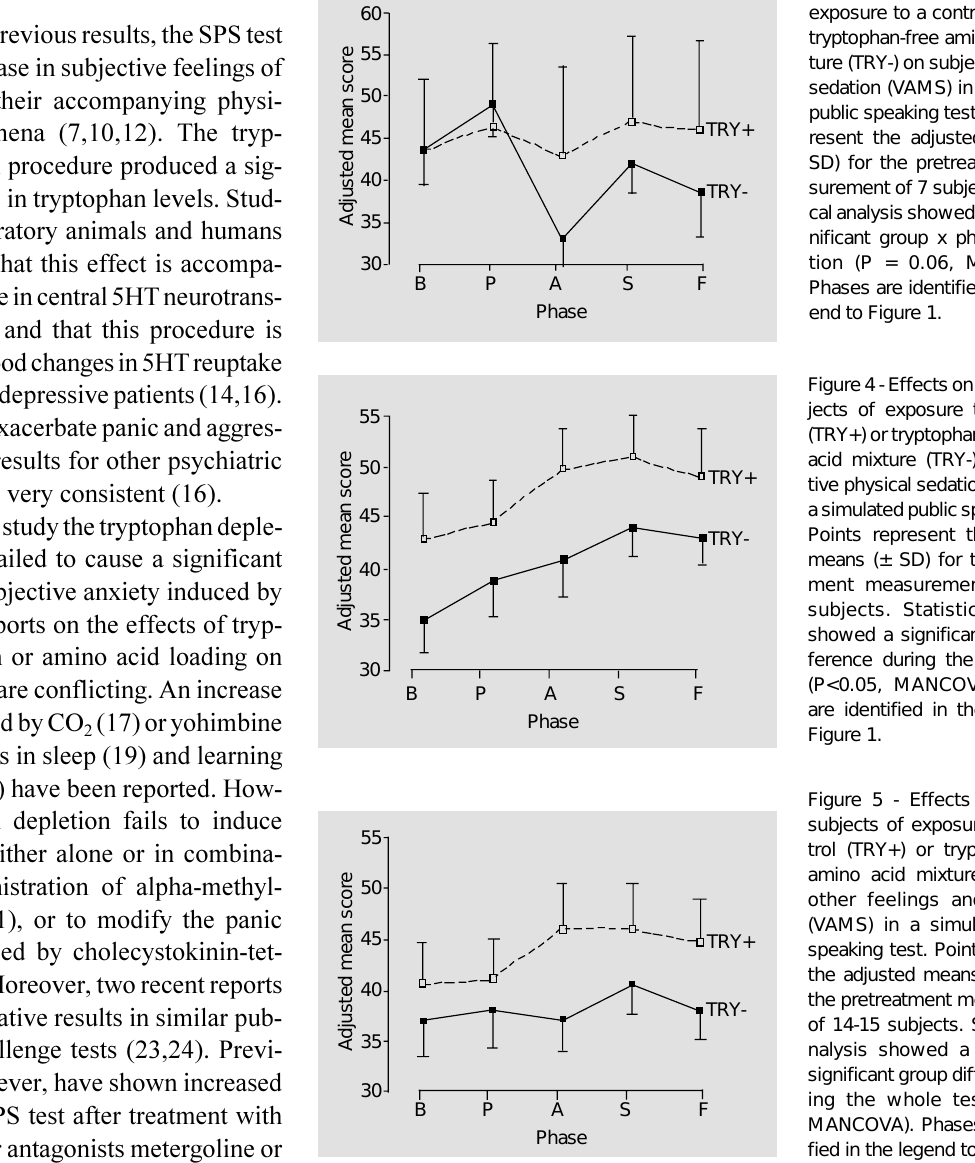
Figure 3 - Effects on females of exposure to a control (TRY+) or tryptophan-free amino acid mix- ture (TRY-) on subjective mental sedation (VAMS) in a simulated public speaking test. Points rep- resent the adjusted means (± SD) for the pretreatment mea- surement of 7 subjects. Statisti- TRY- cal analysis showed a barely sig- nificant group x phase interac- tion (P = 0.06, MANCOVA). Phases are identified in the leg- end to Figure 1.